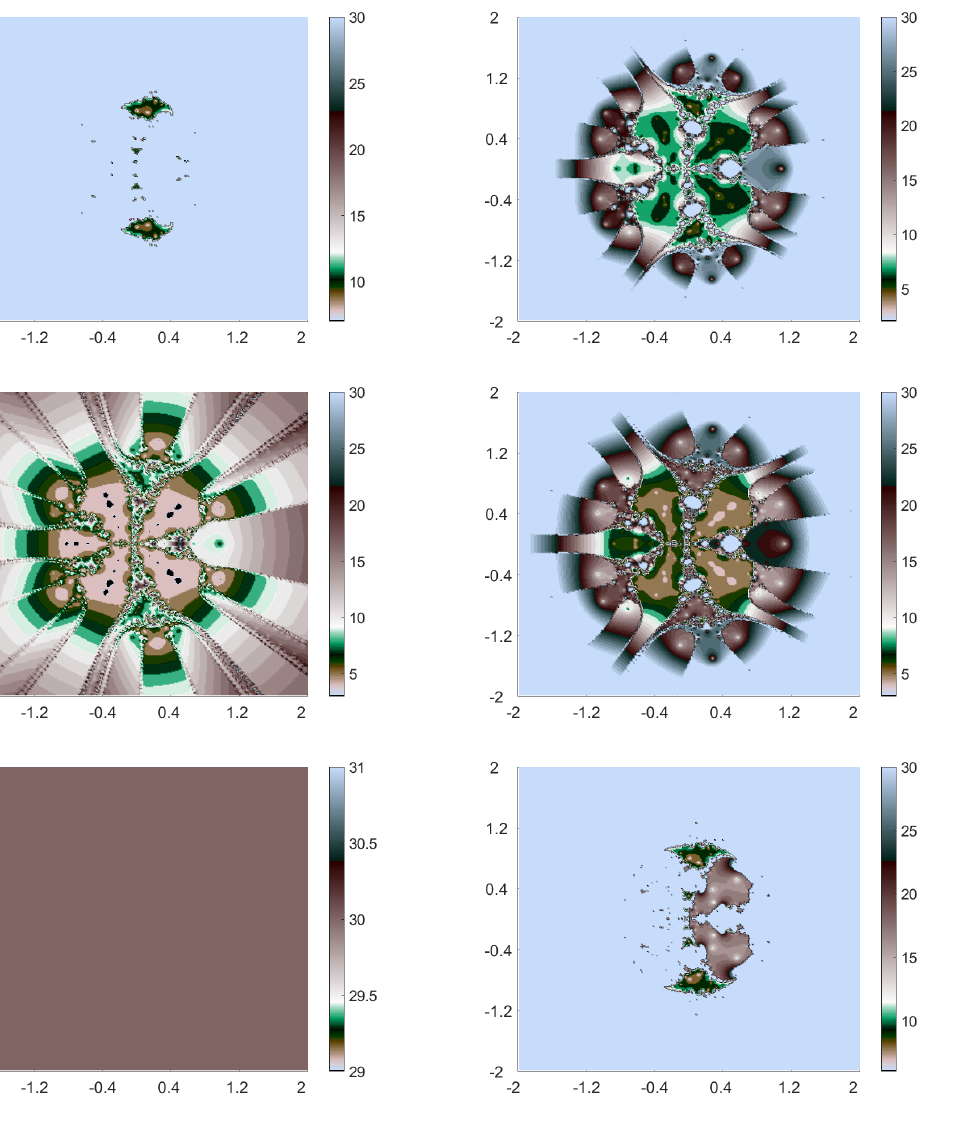
Figure 5. Visualisation of effects of control sequence on polynomiographs for RK iteration with s-convexity, p ( z ) = 5 z 10 + 2 z 7 − z 3 + 3: Case I ( Top Left ); Case II ( Top Right ); Case III ( Middle Left ); Case IV ( Middle Right ); Case V ( Bottom Left ), and Case VI ( Bottom Right